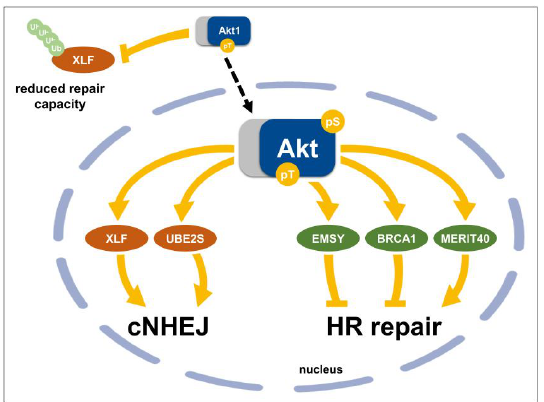
Figure 3. Schematic representation of the interaction of Akt with DNA repair proteins and pathways. Active Akt influences classic non-homologous end joining (cNHEJ) and homologous